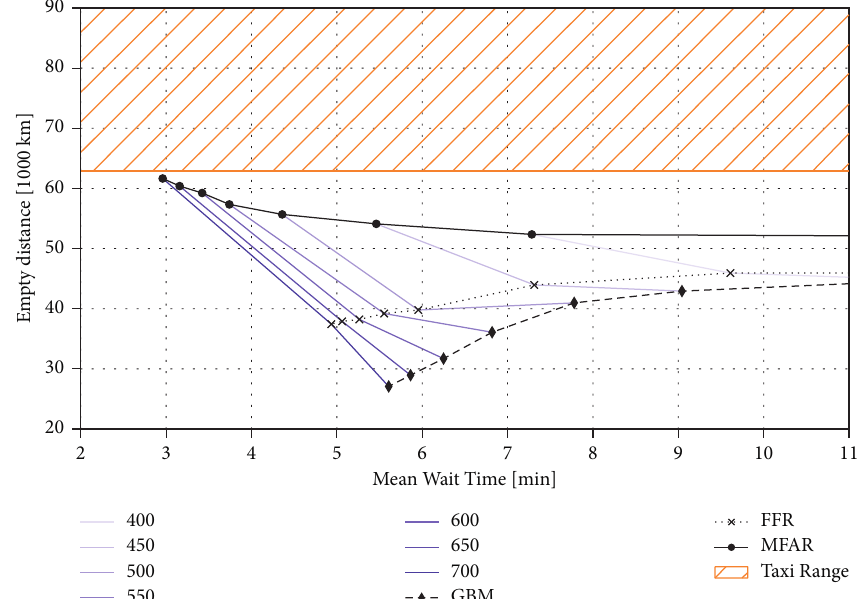
Figure 3: Mean wait time and empty vehicle distance of a coordinated mobility-on-demand system under different operational policies and fleet sizes for the San Francisco case. The real taxi system in orange uses 495 taxis. Wait times lower than in the coordinated system are unlikely but cannot be fully excluded based on the data.